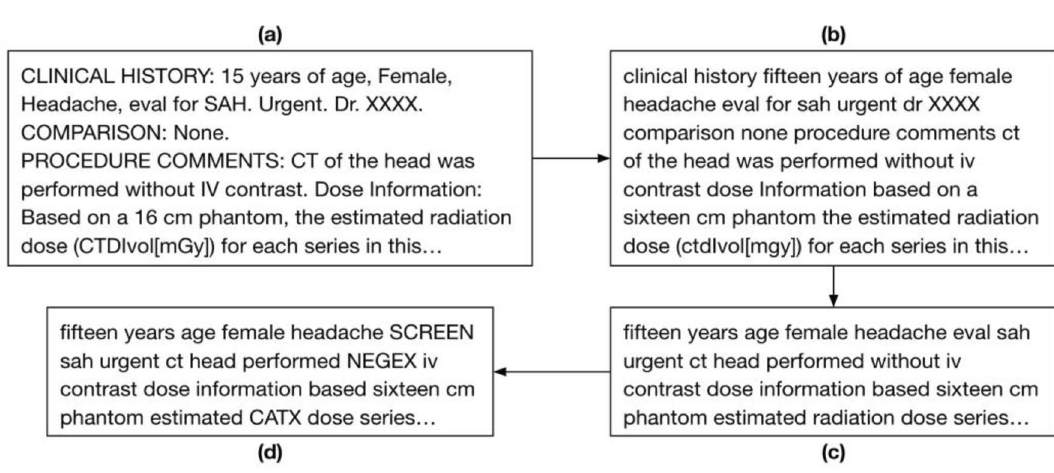
Figure 6. Distribution of visits (left) and follow-up times (right) for all patients in the breast cancer recurrence dataset.